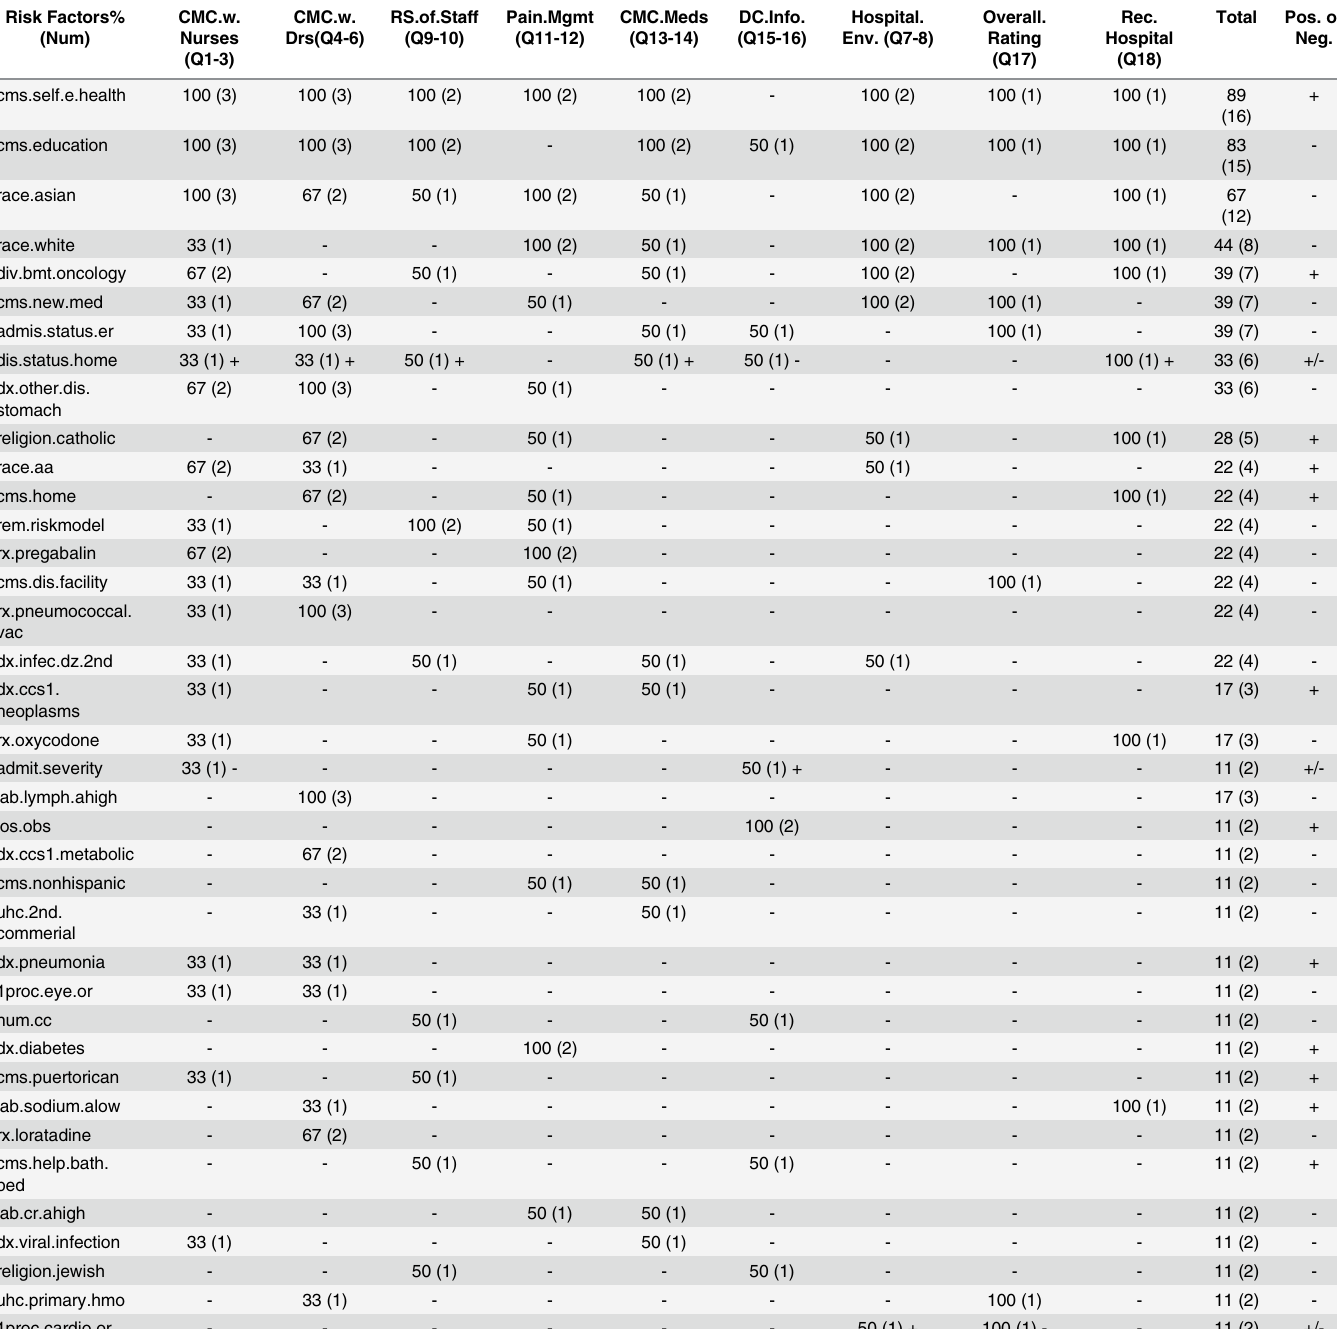
Table 1. Top Ranked Risk Factors for Each Category and